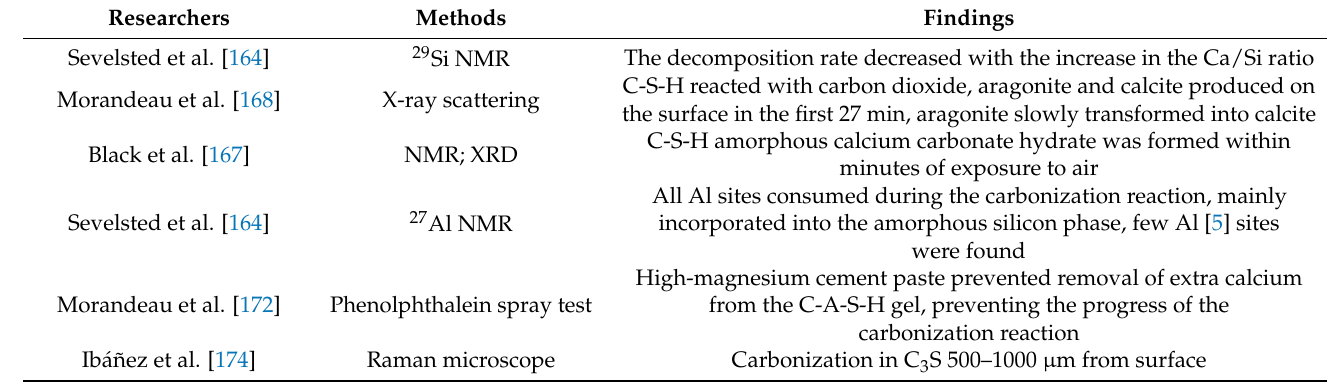
Table 8. Comparing the works on the carbonization of C-S-H made by different researchers. Researchers Methods Findings Sevelsted et al. [164] 29 Si NMR The decomposition rate decreased with the increase in the Ca/Si ratio X-ray